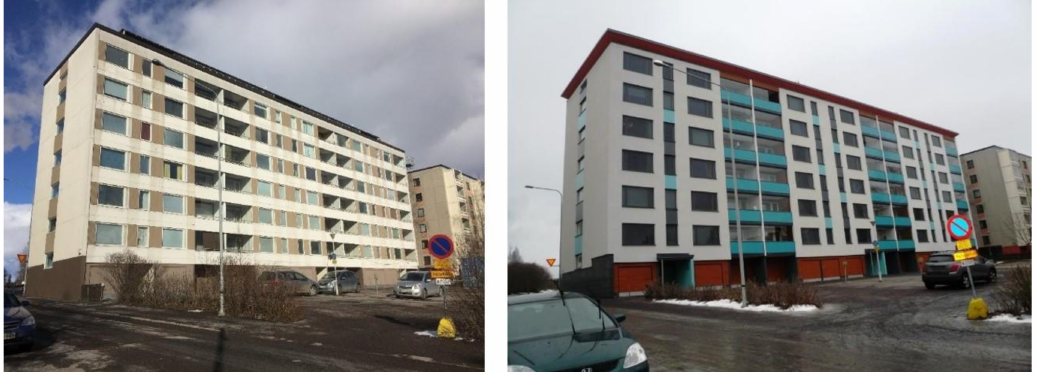
Figure 4. The studied building before and after